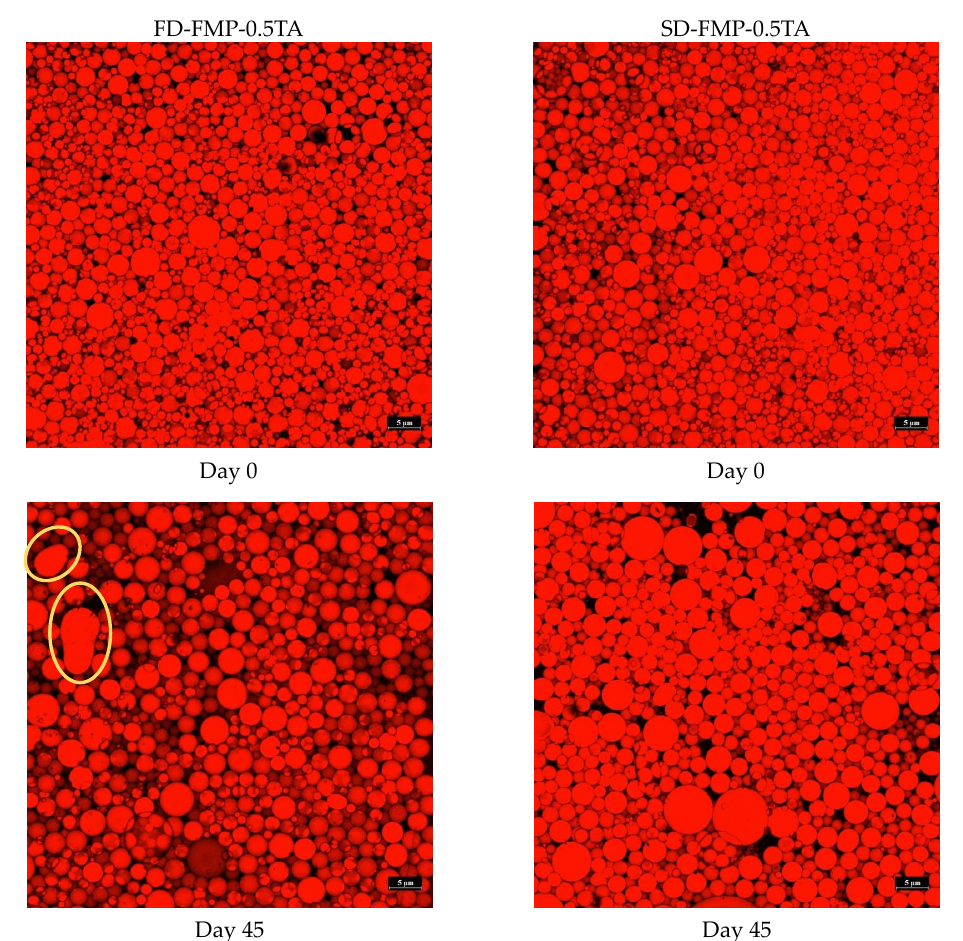
Figure 5. Confocal laser scanning microscopic (CLSM) images of emulsions prepared by freeze-dried (FD) and spray-dried (SD) fish myofibrillar proteins (FMP) modified with 0.5% tannic acid (TA) and stored at day 0 and day 45. Ellipsoidal marks indicate the coalescence of oil droplets.